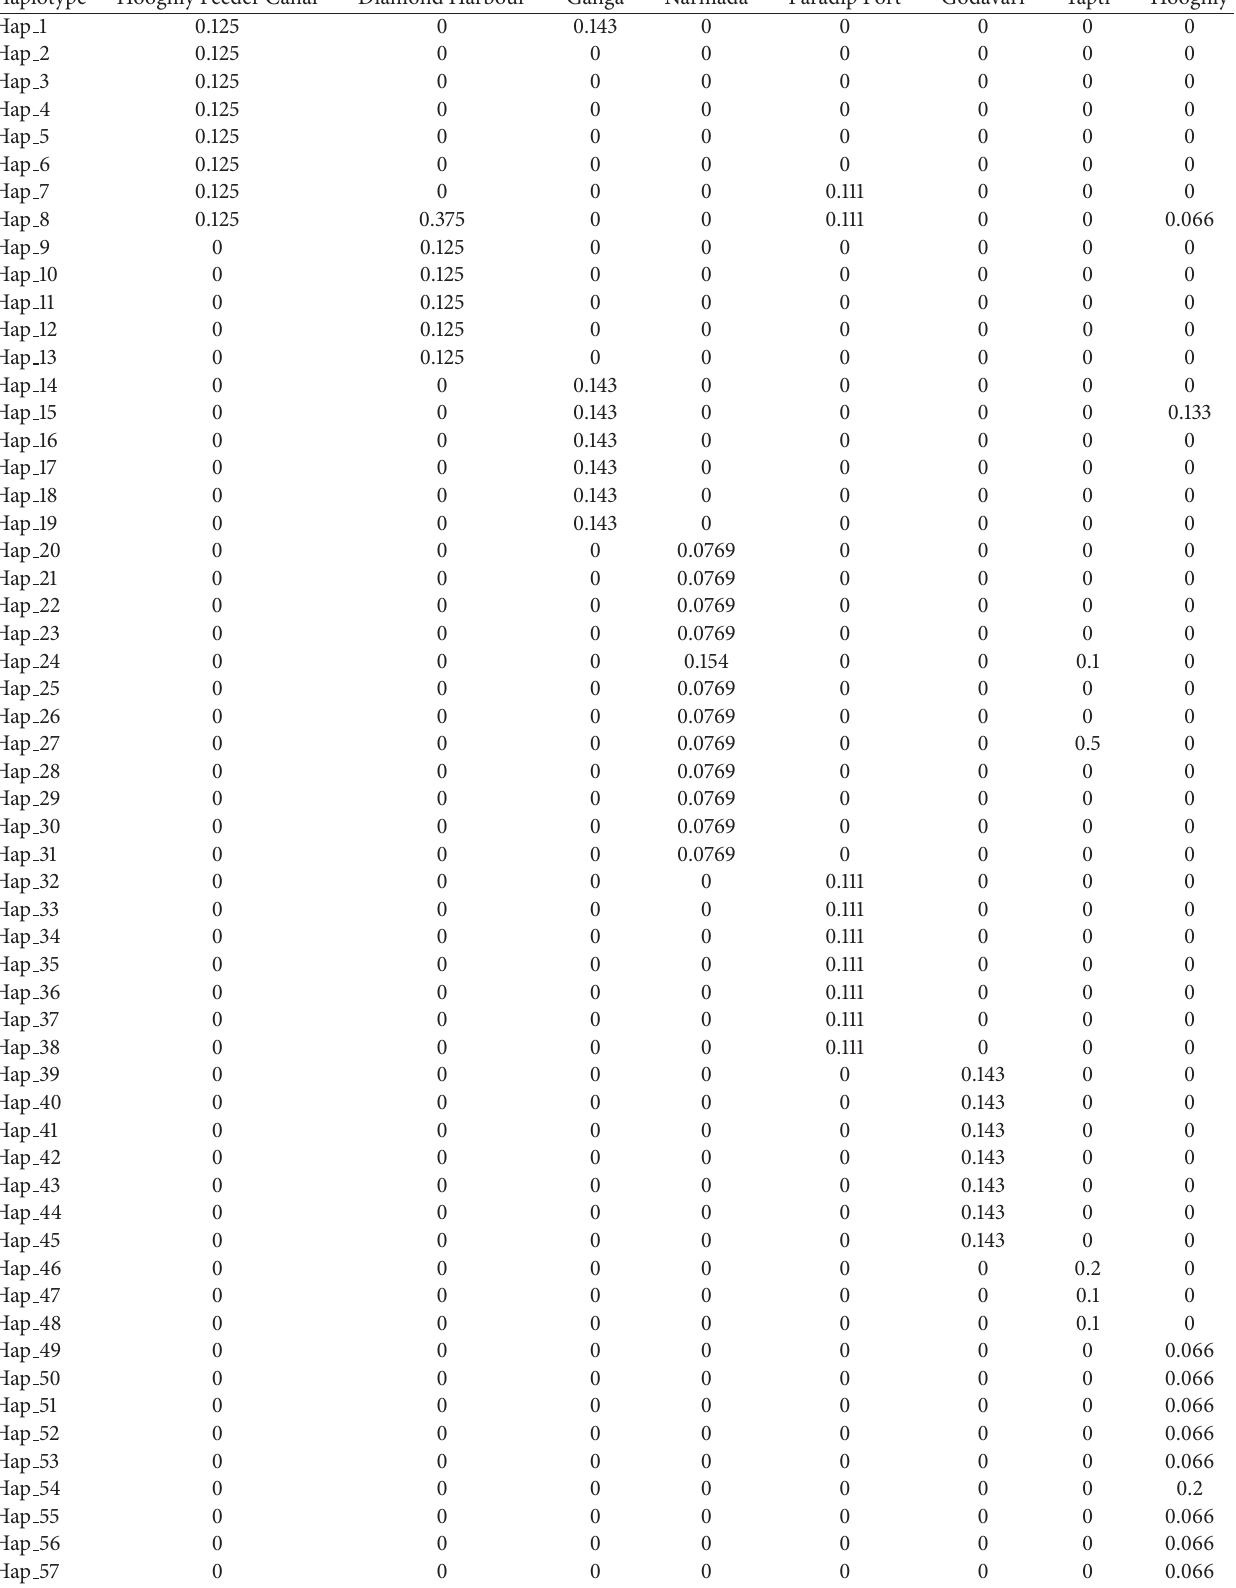
Table 2: Relative haplotype frequencies in different populations of T. ilisha